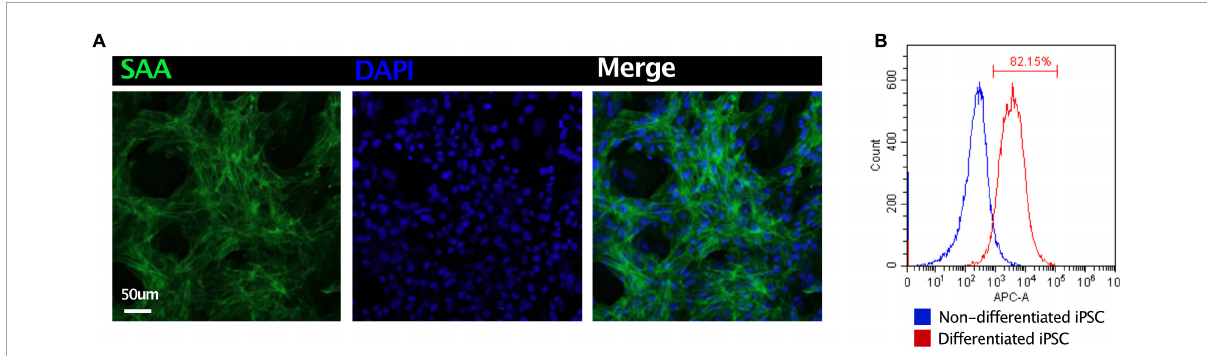
FIGURE4 Quality control of iPSC-derived CMs. (A) Immunostaining of sarcomeric alpha-actinin (SAA) demonstrated the high ratio of CMs. (B) Flow cytometry revealed 82.5% iPSC had been differentiated into CMs.